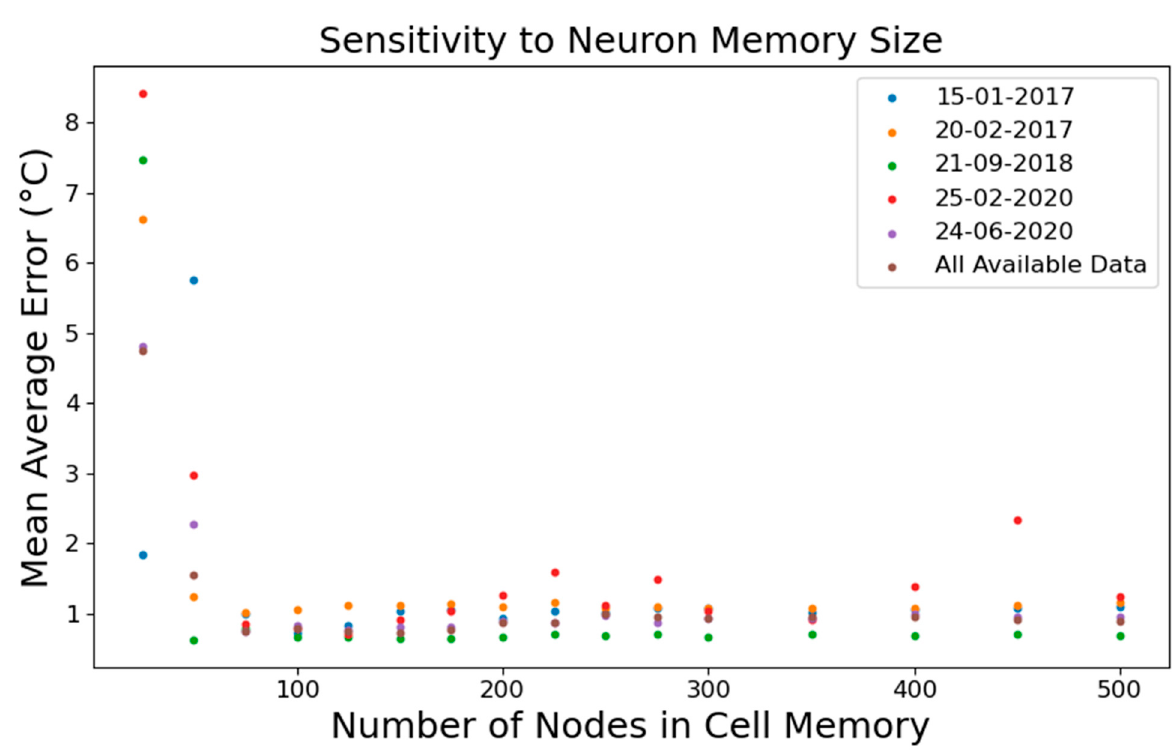
Figure 4. The MAE for each case is insensitive to the size of the internal cell state and hidden layer vectors. In nearly all cases, MAE is around 1 °C or lower.